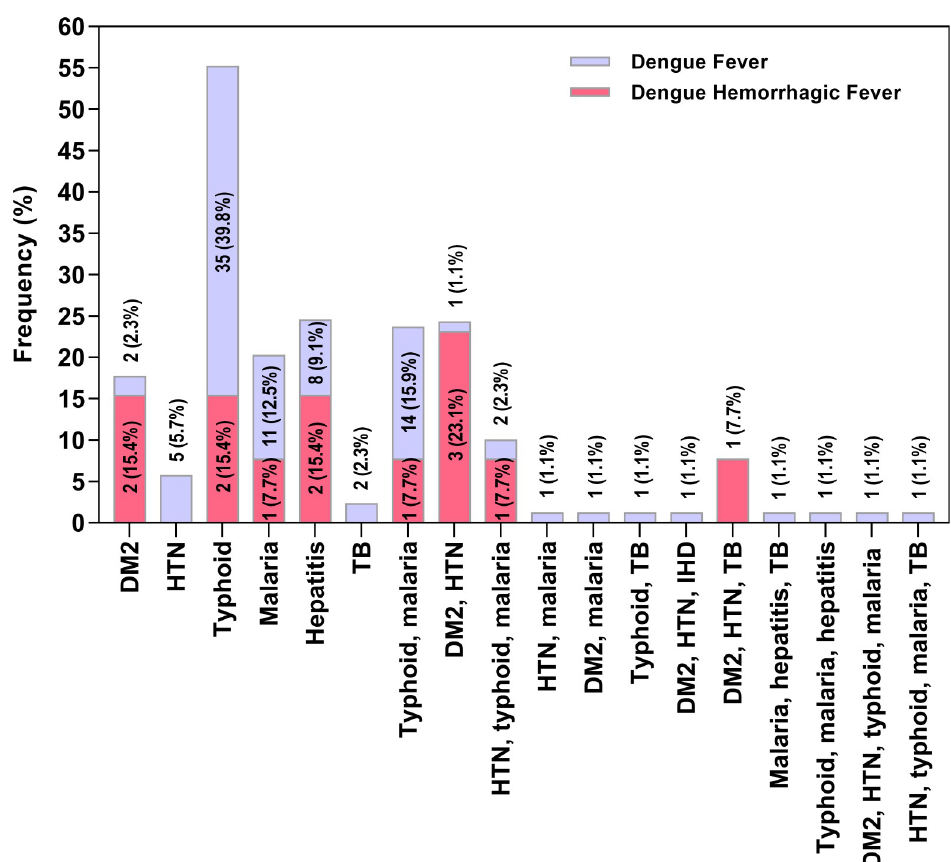
Fig 3. Prevalence of different comorbidities ( n = 101) in patients reported with dengue fever ( n = 88) and dengue hemorrhagic fever ( n = 13). Abbreviations: DM2 = type 2 diabetes mellitus; HTN = hypertensions; IHD = ischemic heart disease; TB =